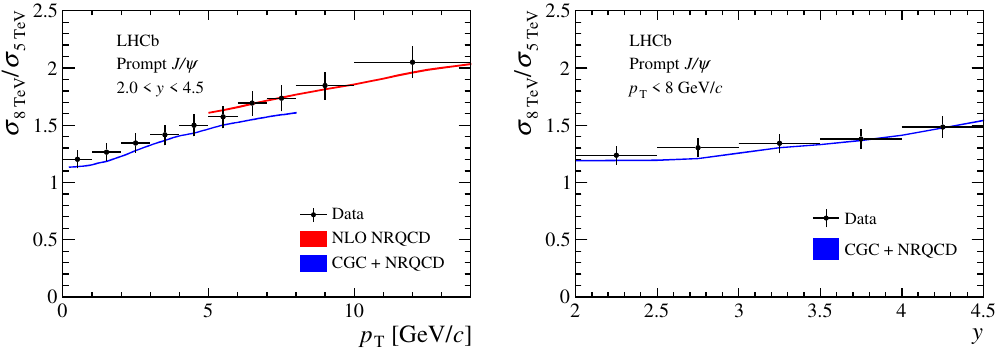
Figure 6 . Ratios of differential cross-sections between 8 TeV and 5 TeV measurements as a function of (left) p T and (right) y for prompt J/ψ mesons compared with NRQCD and CGC calculations [54, 55]. Uncertainties due to the LDMEs determination, renormalisation scales, and factorisation scales are included in the NRQCD and CGC calculations.